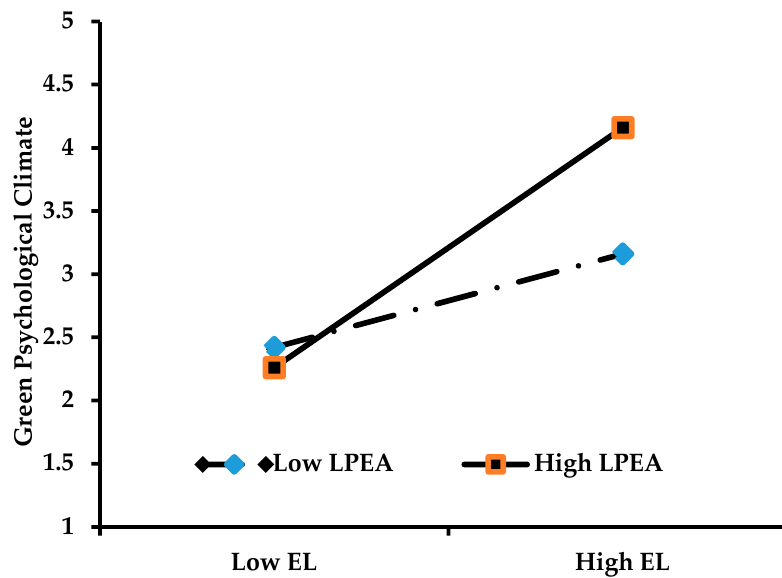
Figure 2. Moderation of Leaders’ Pro-environmental Attitude.